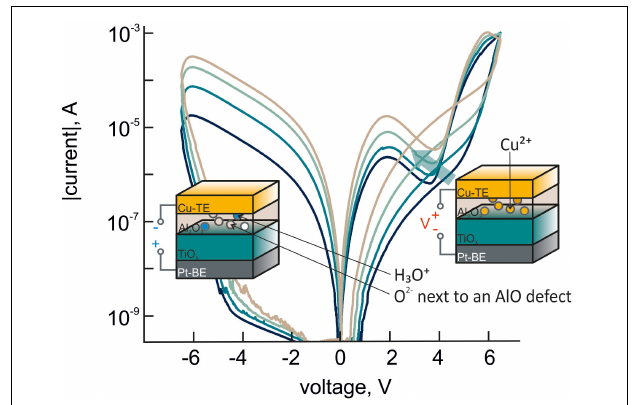
FIGURE 4 | Experimental I-V characteristics of the TiO 2 /Al 2 O 3 bilayer structures with copper electrodes exhibiting an N-shaped